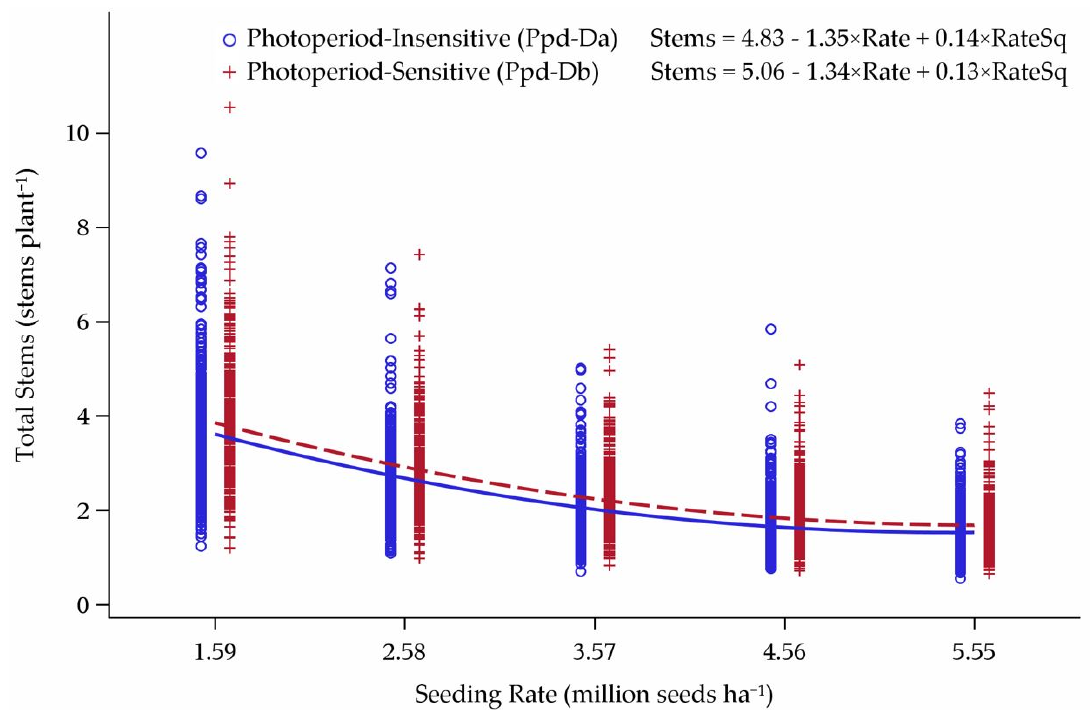
Figure 7. Influence of Ppd-D alleles on tillering response to seeding rate over 21 environments in Minnesota and North Dakota, 2013–2015.